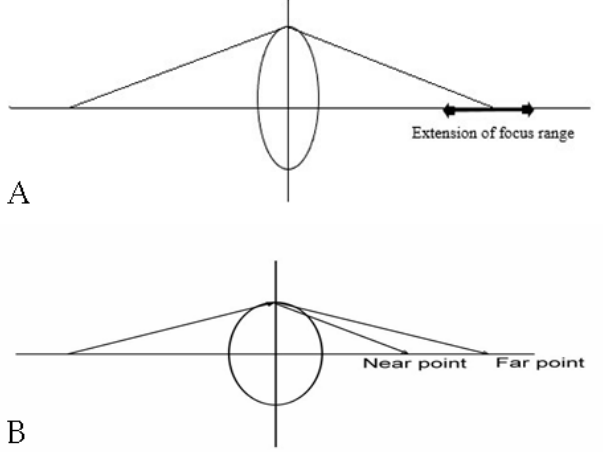
Figure 1. Schematic of extended depth of focus ( A ) and multifocal ( B ) intraocular lens.